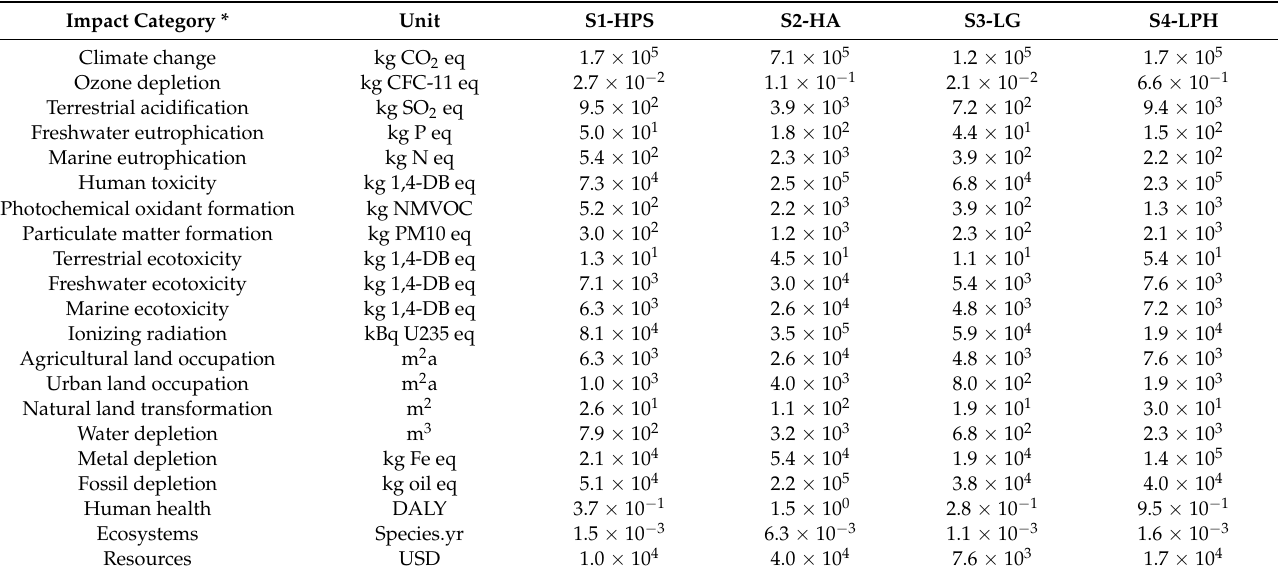
Table 7. Impact contribution of each lighting